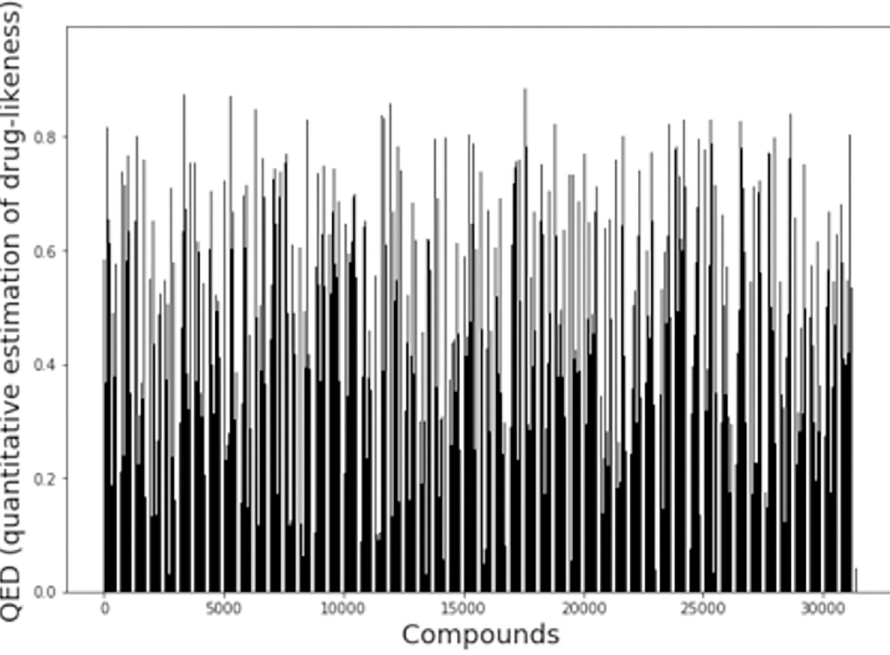
Fig 1. Quantitative estimation of drug-likeness (QED) score of 31401 compounds from natural compound library.